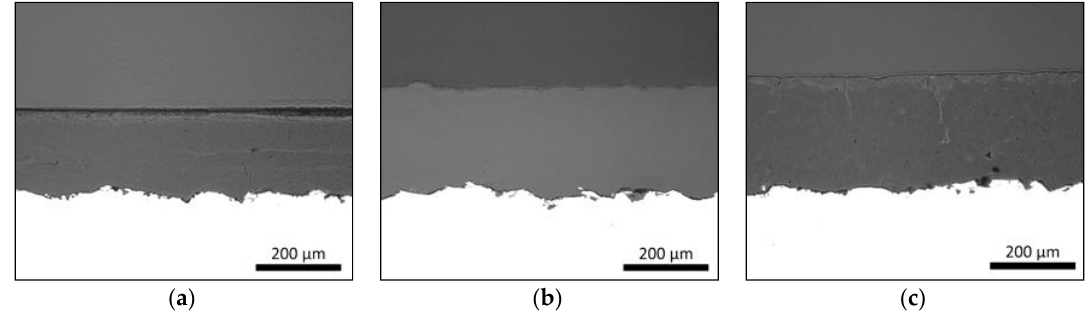
Figure 4. Flame-sprayed polymer ( a ) PE, ( b ) polyether ether ketone (PEEK) and ( c ) polypropylene (PP) coatings (middle part) on steel substrates (white part). Cross-sections. OM images.